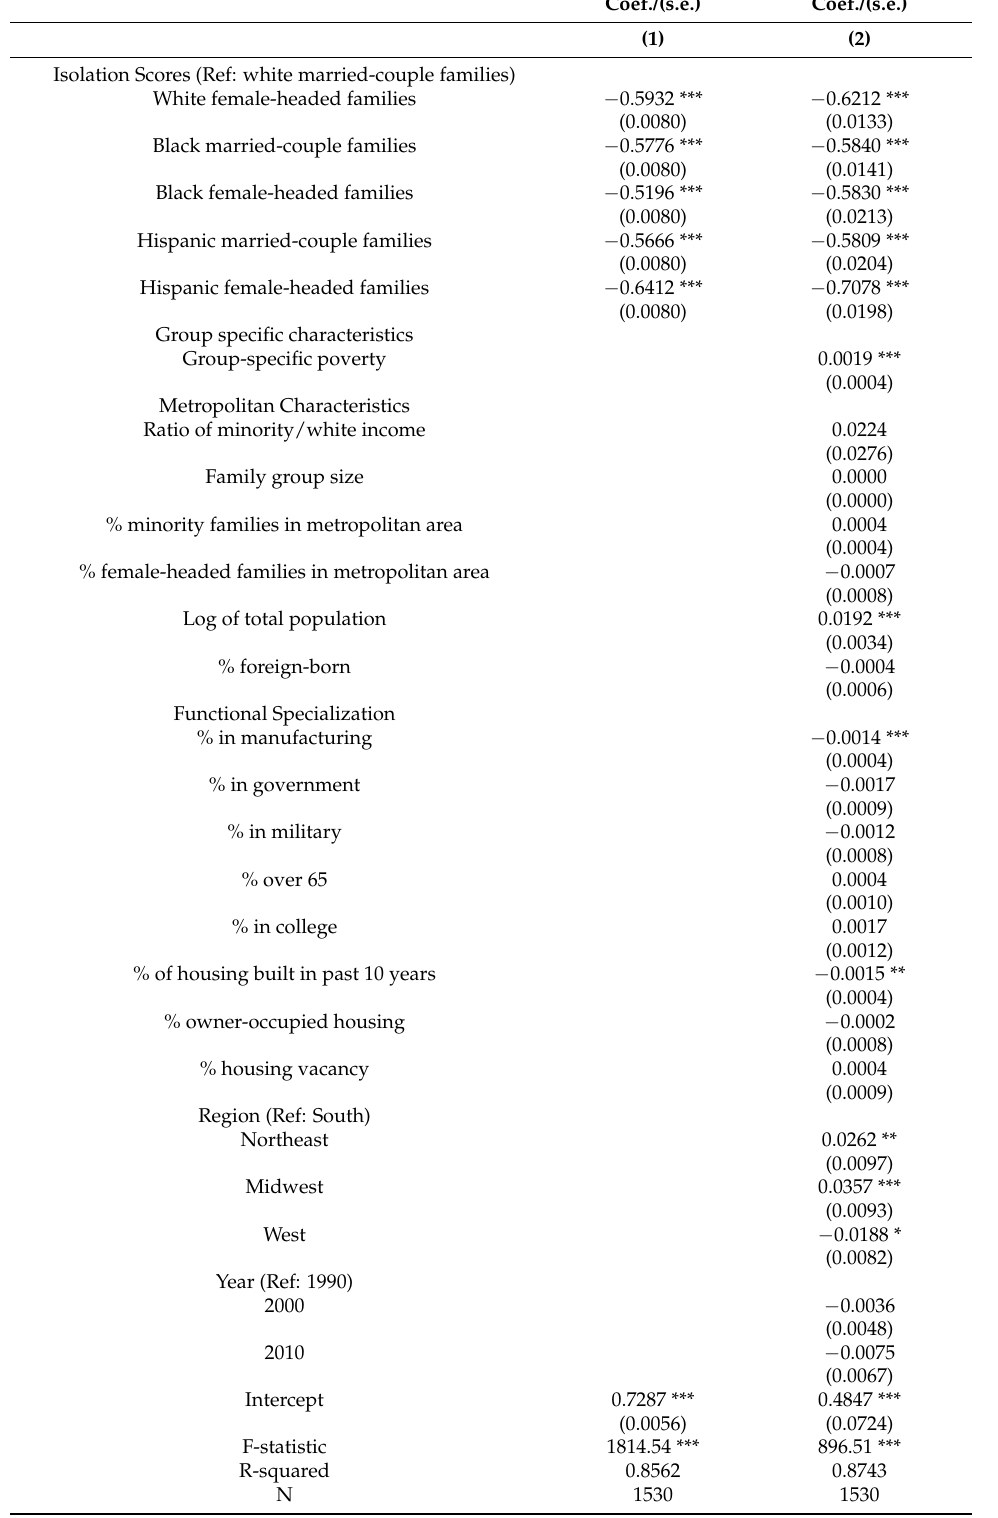
Table 5. Linear regression models of the association between family structure and the Isolation Index relative to white-married couple families, using the 1990–2010 NCDB and 1990–2010